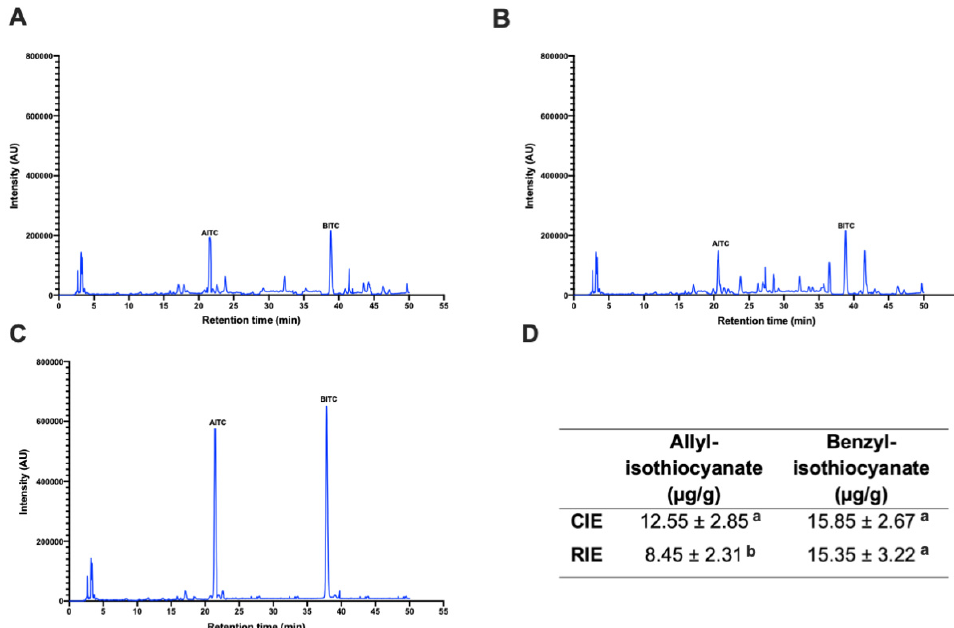
Figure 1. Identification and quantification of allyl isothiocyanate (AITC) and benzyl isothiocyanate (BITC) in the cauliflower isothiocyanate (CIE) and radish isothiocyanate (RIE) extracts. ( A ) Representative chromatogram from CIE; ( B ) representative chromatogram from RIE; ( C ) AITC and BITC standards’ representative chromatogram; ( D ) quantification of AITC and BITC contents in the CIE and RIE extracts. AU: Absorbance units. The results in ( D ) are the mean ± SD of three independent experiments in triplicate. Different letters in ( D ) indicate significant differences ( p < 0.05) by the Tukey–Kramer